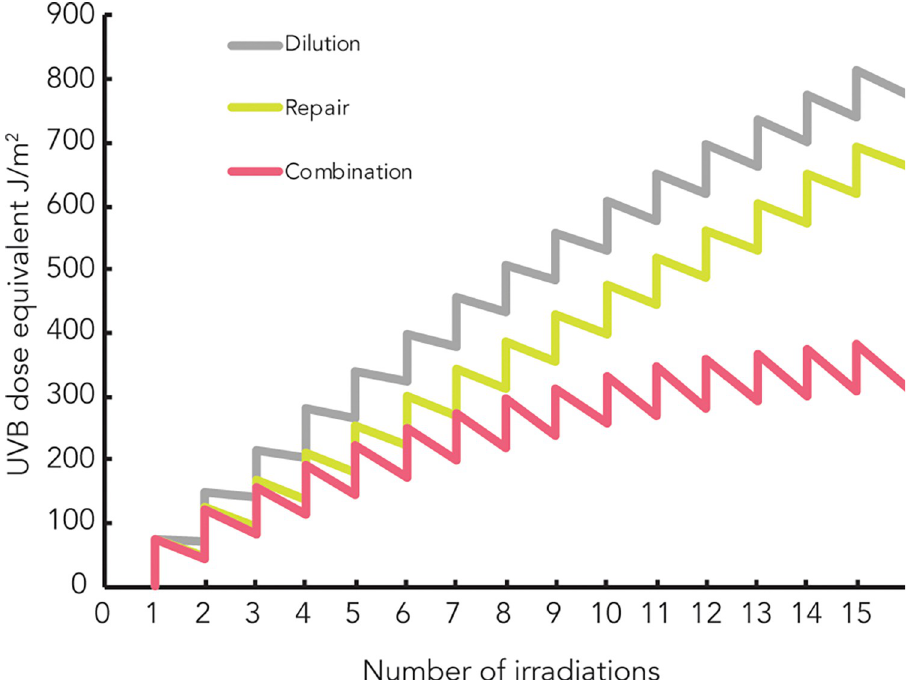
Fig 6. Theoretical model for CPD removal by dilution and repair during a chronic UVB irradiation. We derived a model to predict the amount of CPD, expressed in UVB dose equivalent (J/m 2 ), that remains on DNA during a chronic irradiation. The model take into account the repair and the dilution of CPD after each chronic irradiation. Each individual irradiation from the CLUV protocol leads to an induction of CPD, represented by an increase of 75 J/ m 2 UVB equivalent. Repair of the newly induced CPD after each CLUV irradiation was modeled using the acute repair efficiencies we measured between 0 h-12 h (35.3% of new damage repaired) and 12 h-24 h (9.8% of remaining damage) (green line). Rate of CPD removal by dilution was determined using the equation of the regression line for the CLUV treatment (y = -0.4012x + 100.53). It was applied to all the remaining damage (grey line). CPD reduction from DNA repair and dilution were combined (red line). Using this model, we determined that the theoretical amount of CPD induced by the chronic irradiation represents approximately the level induced by 312 J/m 2 of UVB. This corresponds to 28% of the CLUV-induced CPD that persist on the DNA. We found that the actual measured amount induced by the CLUV protocol is similar (273 J/m 2 ), validating our model.